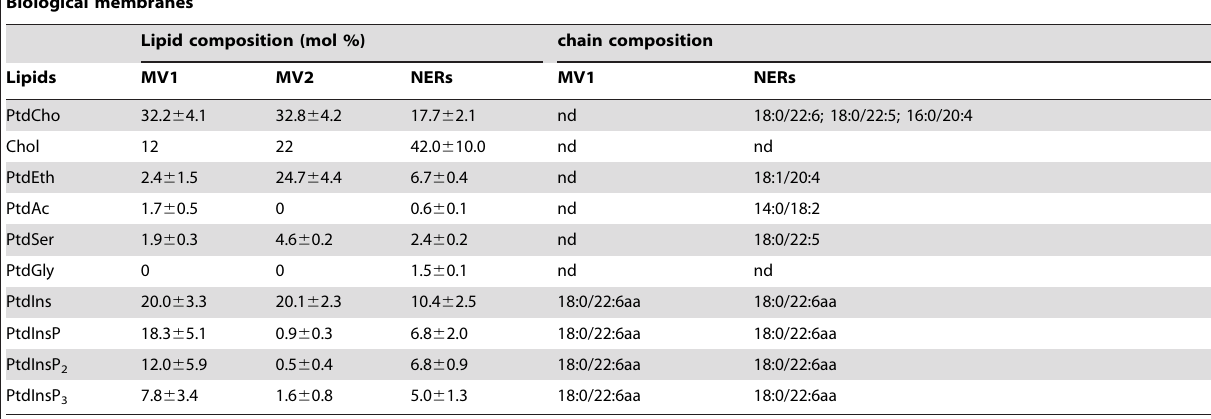
Biological membranes Lipid composition (mol %) chain